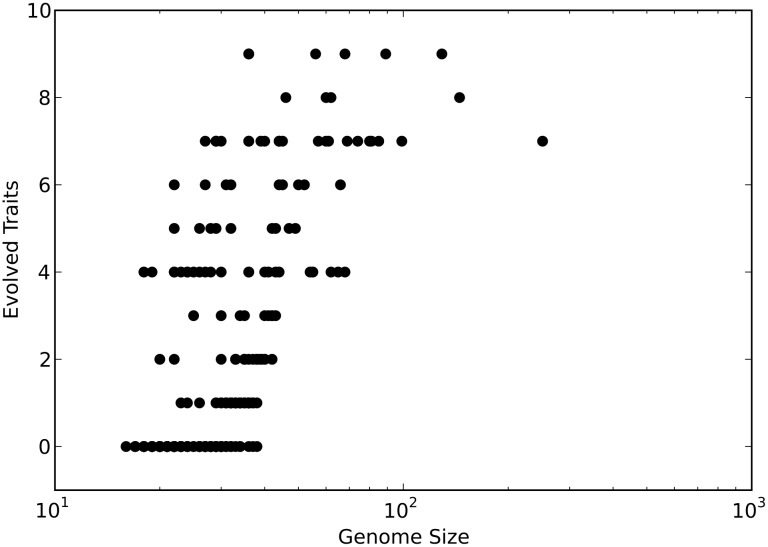
Correlation between the final genome size and the final number of evolved traits.Black circles represent the combined data from populations with 10, 100, 1000, and 10000 individuals. Only replicates that survived all 2.5×105 generations were included.